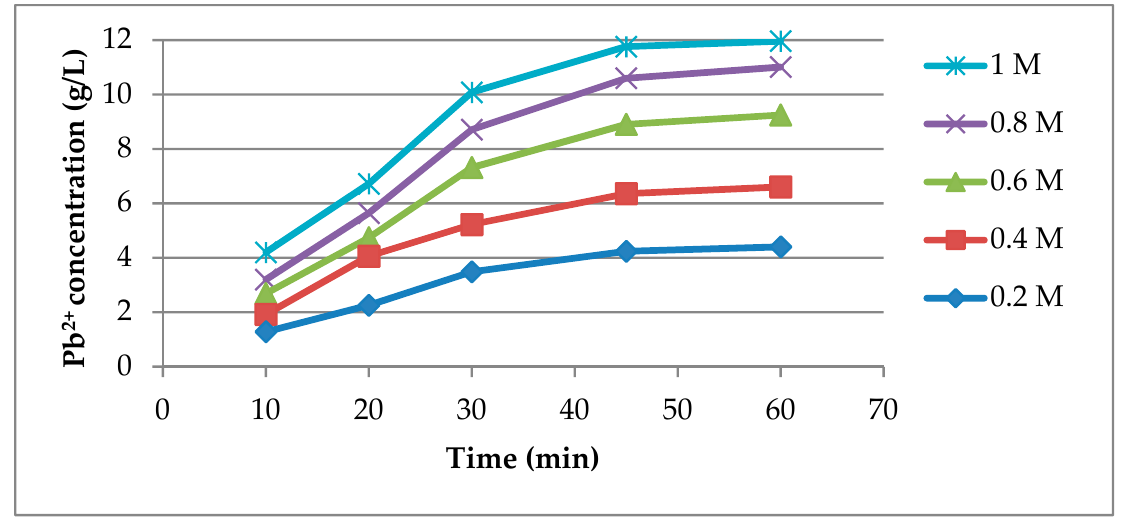
Figure 3. Pb 2+ concentration profile at different CH 3 COOH concentrations. Considering that the above evaluated performance indicators give contradictory conclusions regarding the optimal CH 3 COOH concentrations, the specific acetic acid con- sumption for the leaching process was determined which gives a comprehensive overview on the efficiency of the process. The specific acetic acid consumption values, Figure 4, show that the lowest concentration (0.2 M) of CH 3 COOH allows the most efficient use of the amount of leaching agent present in the system. In contrast, according to Figure 3, the final Pb 2+ concentration is the lowest at 0.2 M of CH 3 COOH which would not ensure the most favorable conditions for the electrodeposition process of lead. Therefore, the intermedi- ate concentration of 0.6 M CH 3 COOH would be a better option in comparison to 0.2 M CH 3 COOH, considering that the obtained final Pb 2+ concentration (9.25 g/L) represents 80% of the maximum achievable concentration under these dissolution conditions.